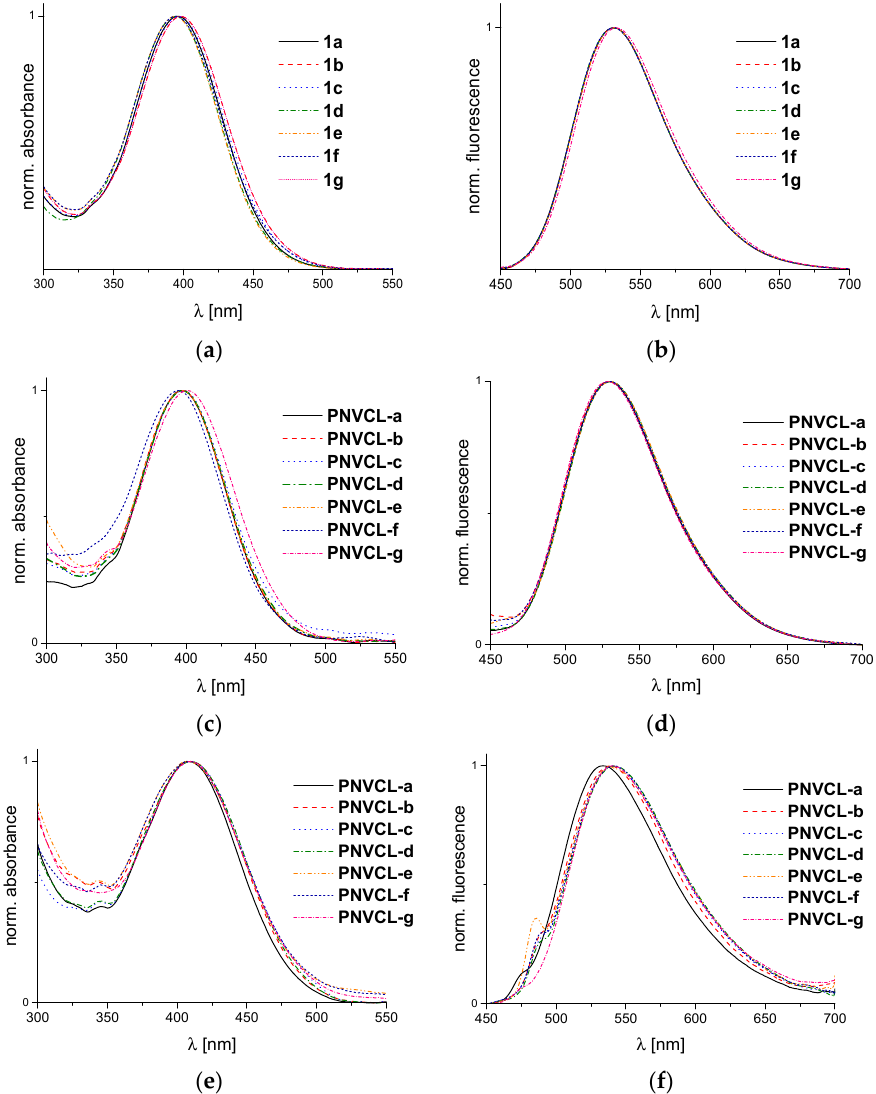
Figure 3. Normalized UV-VIS and fluorescence spectra of dye monomers and dye-labeled copolymers in solution (21 °C): ( a ) absorbance spectra of dye monomers 1a – 1g in ethanol; ( b ) emission spectra of dye monomers 1a – 1g in ethanol ( λ Exc = 400 nm); ( c ) absorbance spectra of copolymers PNVCL-a – PNVCL-g in ethanol; ( d ) emission spectra of copolymers PNVCL-a – PNVCL-g in ethanol ( λ Exc = 396 nm); ( e ) absorbance spectra of copolymers PNVCL-a – PNVCL-g in water; and ( f ) emission spectra of copolymers PNVCL-a – PNVCL-g in water ( λ Exc = 409–418 nm).